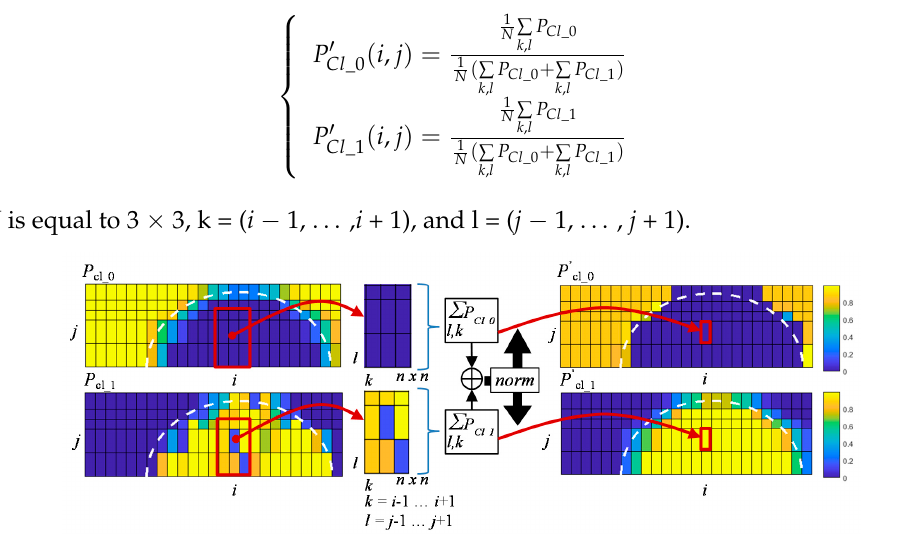
Figure 11. Visualization of the neighborhood based class probability update algorithm for the DCNN DND case.